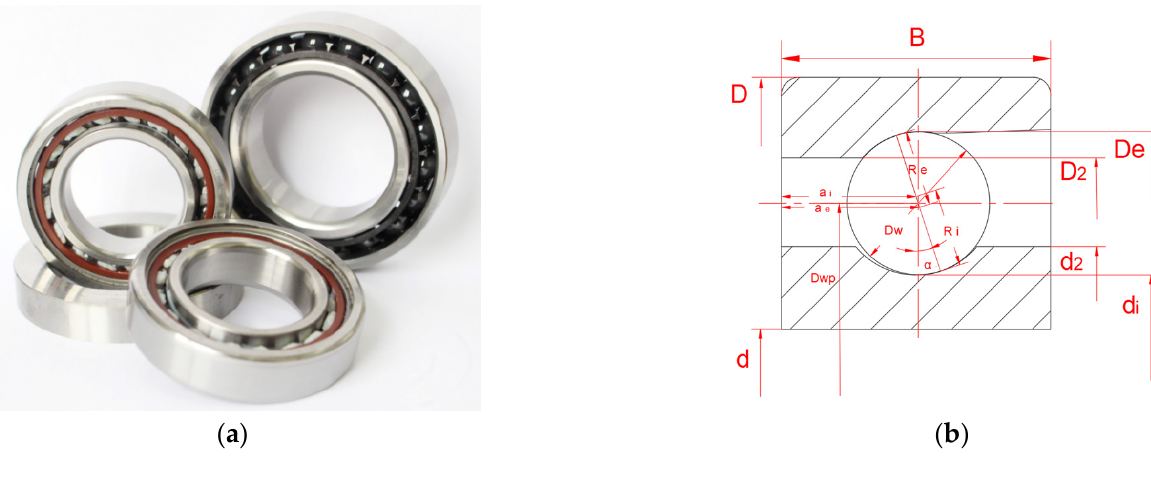
Figure 1. ( a ) Angular contact ball bearing 7008C and ( b ) important parameters in the simplified principal